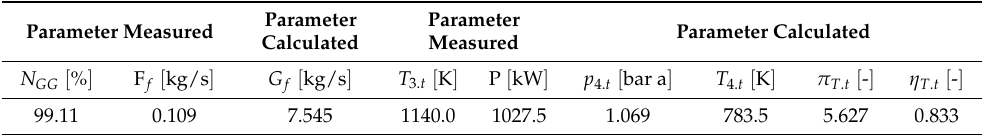
Table 7. Measured and calculated parameters at maximum working regime on the test bench, part